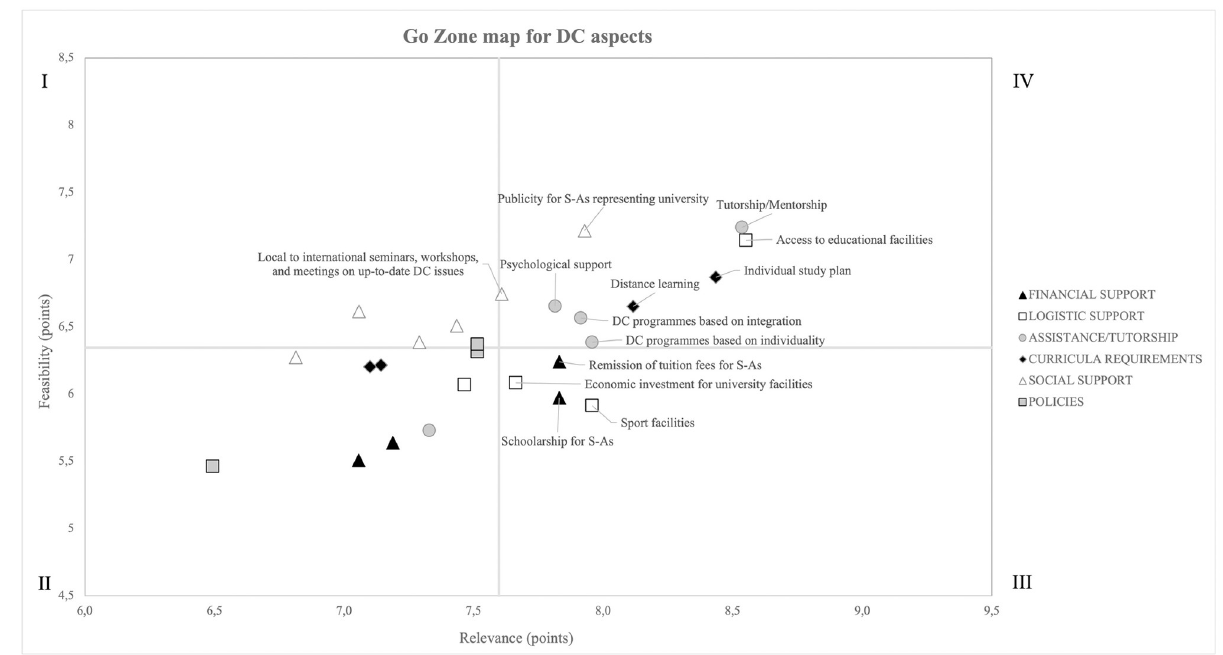
Fig 1. Go zone map of relevance and feasibility of implementation of dual career aspects. Quadrant I includes aspects deemed feasible but considered to have a low relevance; Quadrant II includes aspects with low relevance and feasibility; Quadrant III includes aspects deemed relevant but considered to have low feasibility; Quadrant IV includes aspects deemed both feasible and with high